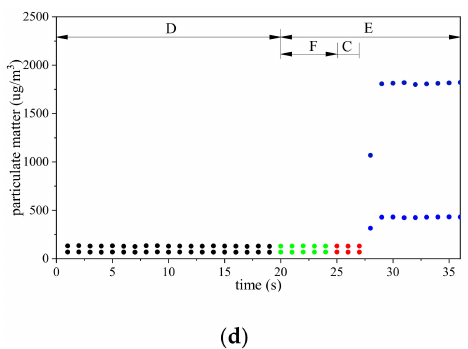
Figure 7. ( a ) CO 2 concentration values in the experimental of CO 2 sensor delay. ( b ) CO 2 concentration values in the experimental of time required to discharge residual CO 2 gas in UGSS. ( c ) Particulate matter (PM) PM2.5 / PM10 concentration values in the experimental of CO 2 sensor delay. ( d ) PM2.5 / 10 concentration values in the experiment of time required to discharge residual CO 2 gas in UGSS.